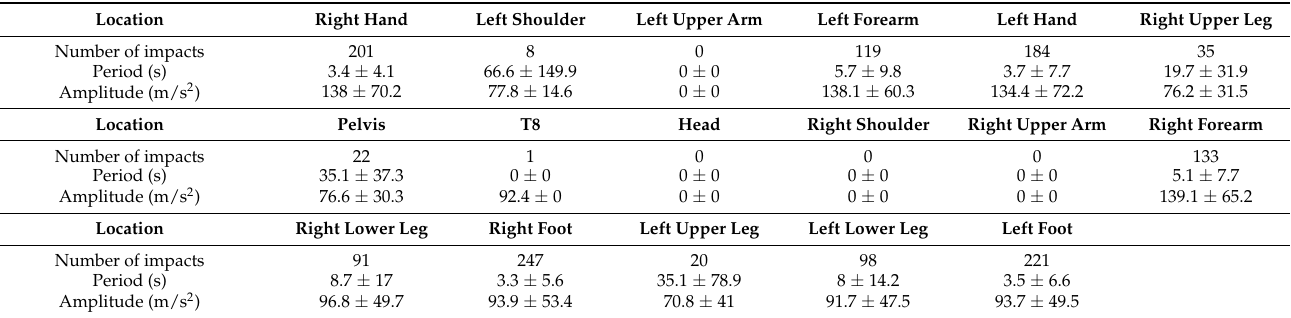
Table 3. Impact characteristics for each location. Mean and standard deviation (SD) are shown for period and amplitude features (mean ±